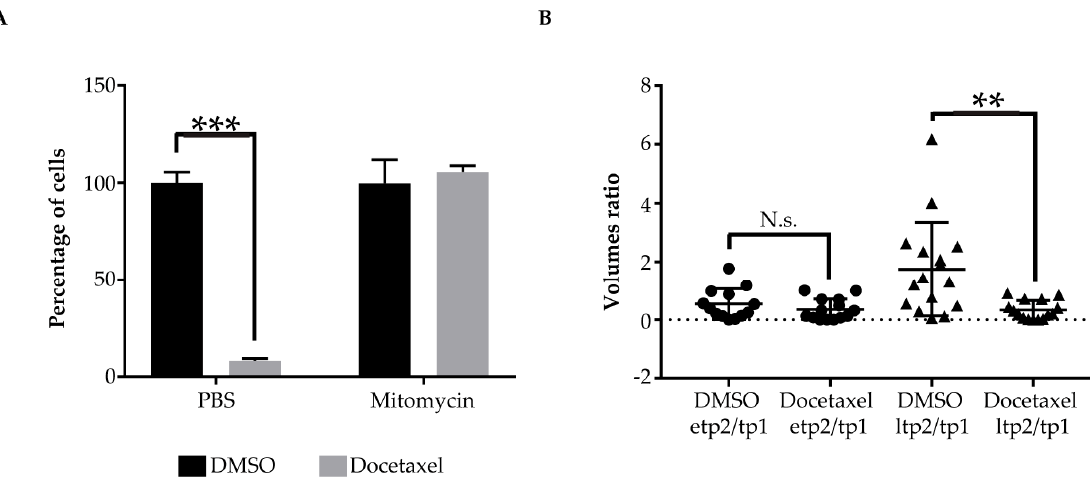
Figure 5. Addressing drugs MoA ( A ) bar graphs showing percentages of HCT116 cells surviving after incubation with mitomycin C or PBS control and subsequent treatment with docetaxel or DMSO control. Three cell counts were performed per condition. Results are represented as mean +/ − standard deviation; ( B ) scatter dot plot of the tumor volume ratios between etp2 and tp1 and ltp2 and tp1 of HCT116 xenografts treated with Docetaxel or DMSO control. Tp1 corresponds to 24 hpi, etp2 to 96 hpi and ltp2 to 144 hpi. Each dot or triangle in the graphs represents the measurement of a fish. * indicates p < 0.05, ** means p < 0.01, 3 *** signify p < 0.001, and **** stays for p < 0.0001. No statistical significance is indicated by ns.